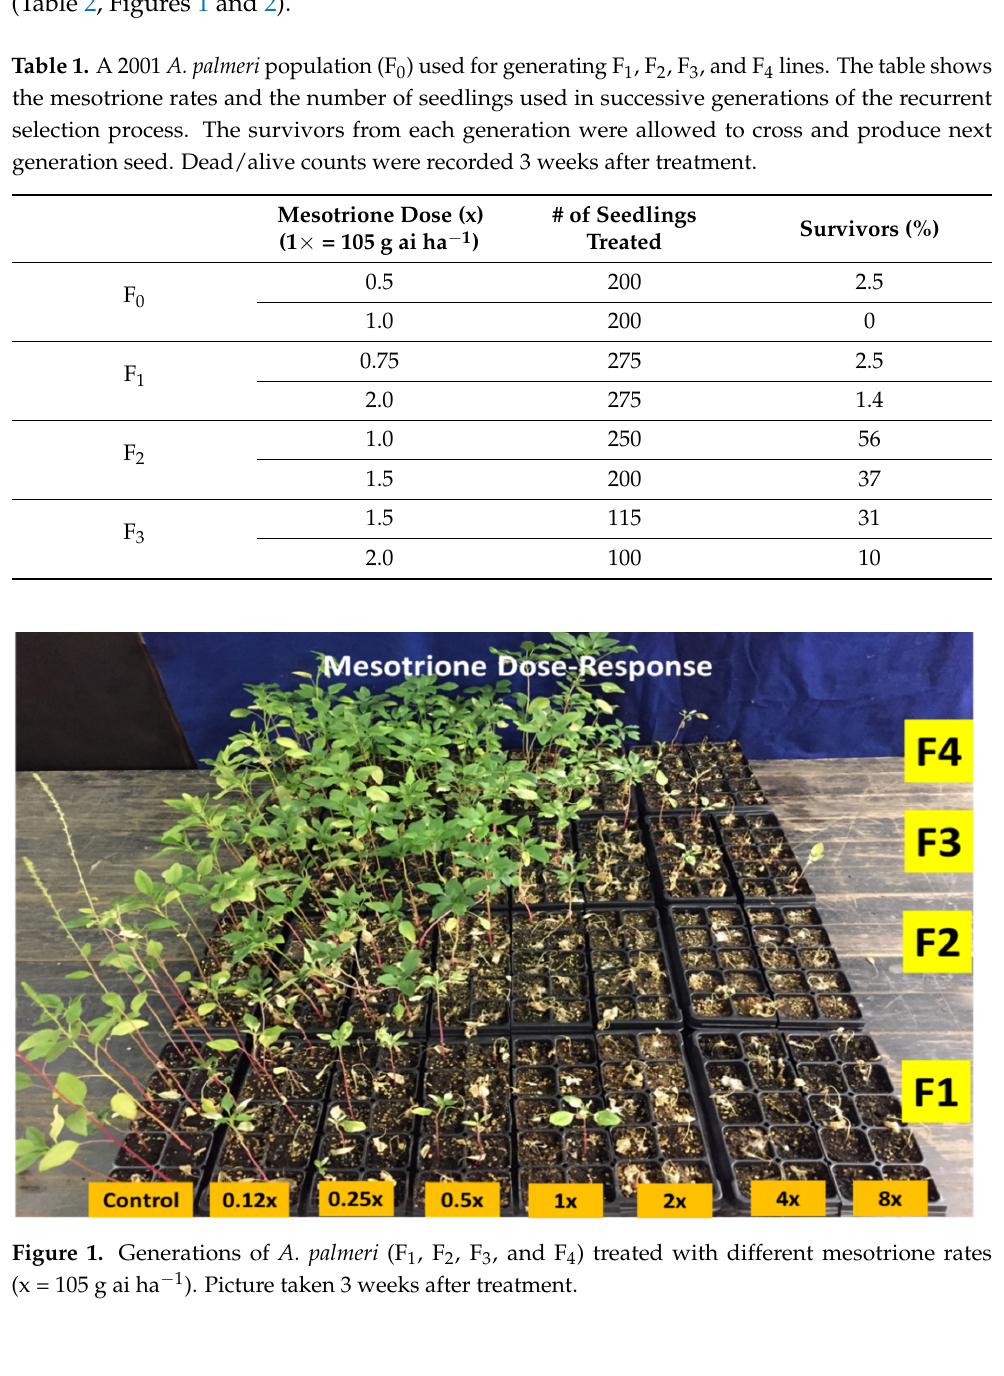
Figure 2. Dose–response curves for generations of A. palmeri (F 0 –F 4 ) selected following sub-lethal doses of mesotrione in the greenhouse. 2.2. HPPD Gene Expression In this study, increased HPPD expression levels were observed in the F 3 generation (Figure 3). HPPD expression remained low (near to F 0 levels) until the F 2 , and a sudden spike was observed at the F 3 generation. The population had a 1.5-fold reduction in re- sponse to mesotrione at F 3 .